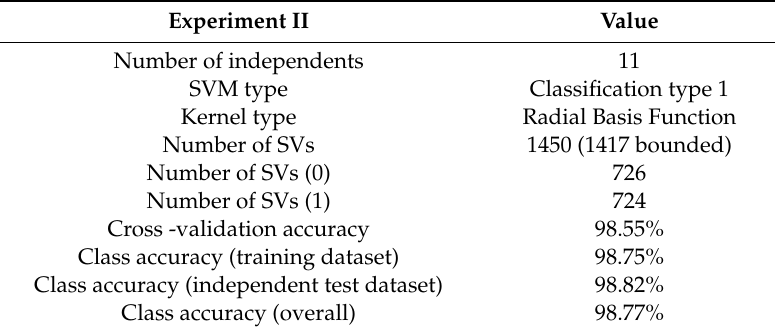
Table 3. Experiment II model summary ( ψ = 0.8, C = 3).